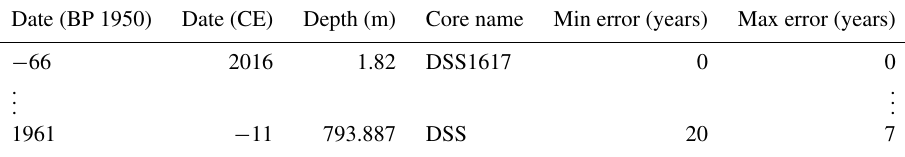
Table 2. Column headings for the file “DSS_2k_age_horizons.csv” which contains the depths of year boundaries produced by annual layer counting methods. Year horizons by depth are provided along with the specific core used for that year in the compilation. Accumulated minimum and maximum errors in age are provided, calculated using the method described in Sect.